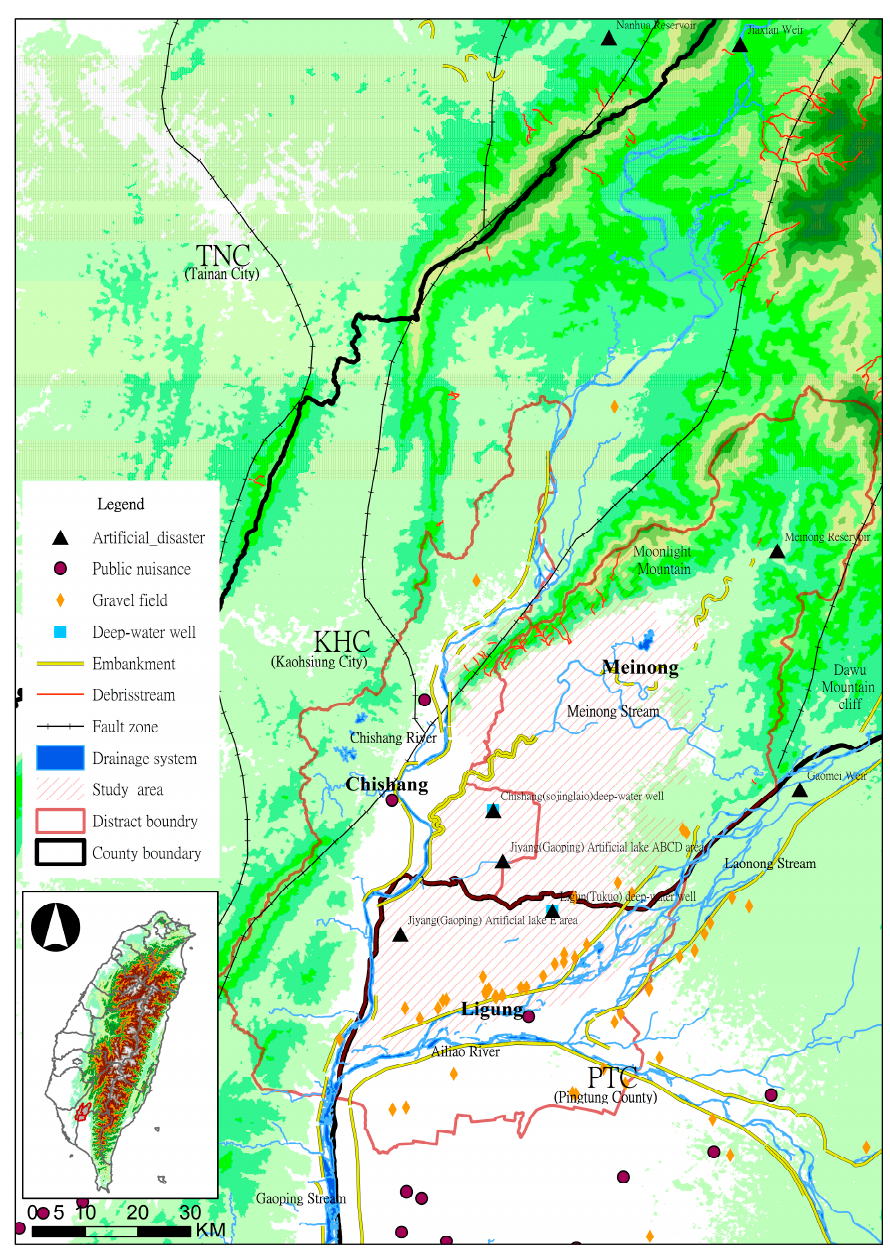
Figure 5. Spatial distribution of artificial disasters on the Meinong Plain.